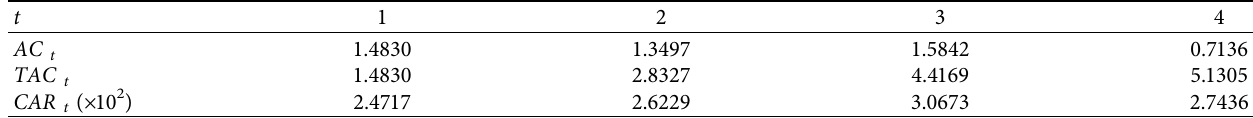
Table 8: .e termination condition judgment.